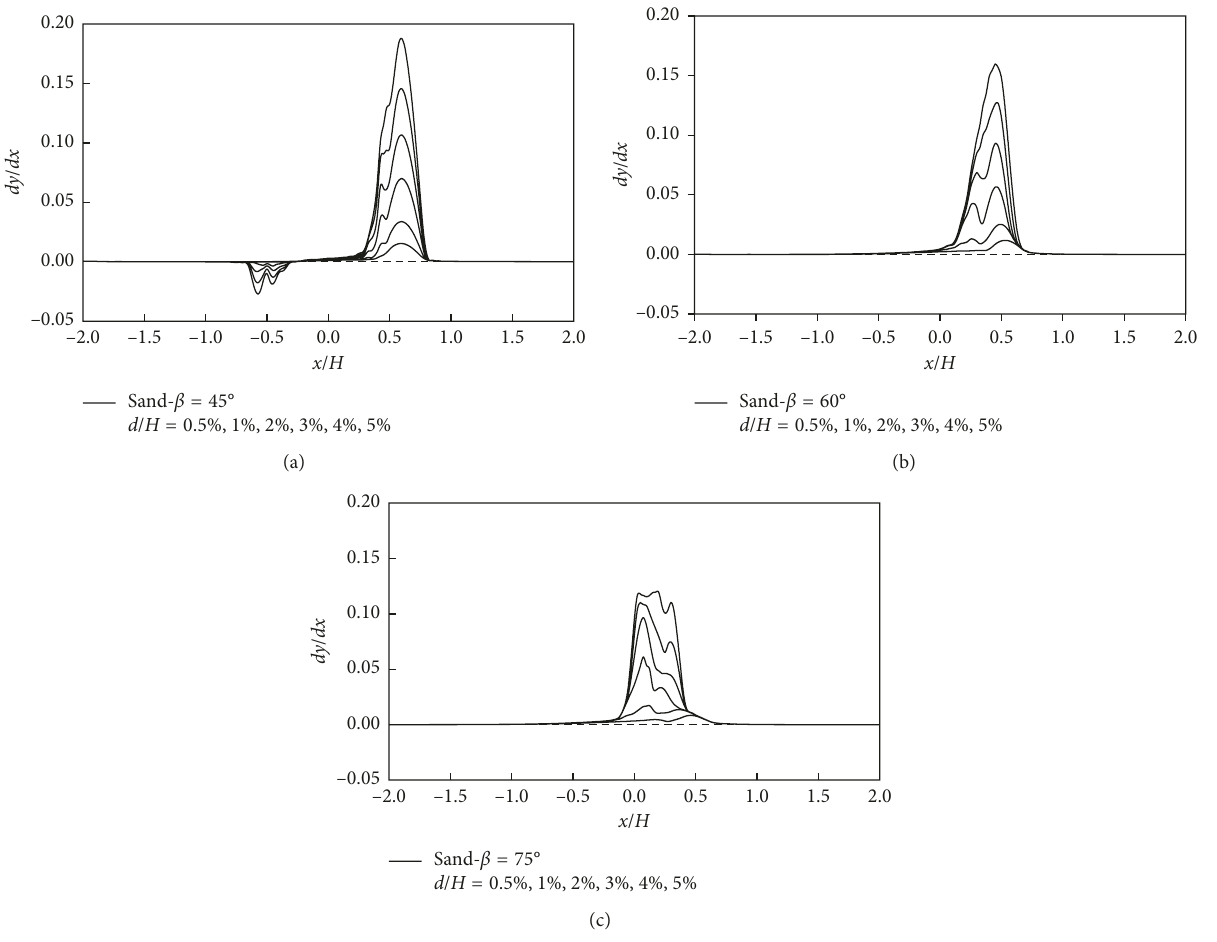
Figure 11: The ground incline curves with different dip angles for the normal fault in sand: (a) 45 ° , (b) 60 ° , and (c) 75 °